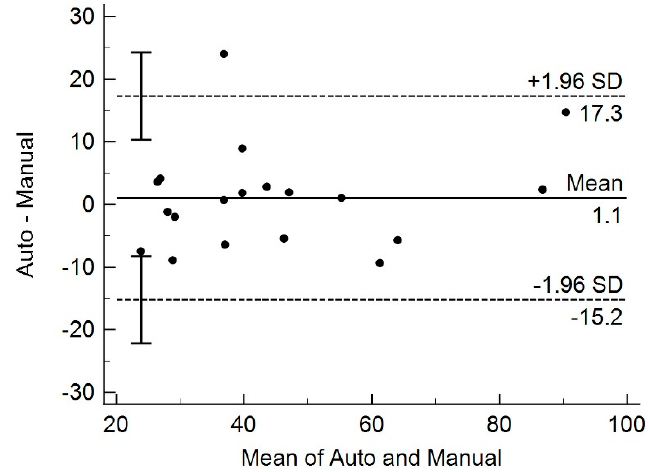
Figure 4. Bland–Altman plot of prostate volume measured by automatic and manual methods. All but one measurement differed within 1.96 standard deviation, indicating no systematic variation between the two measurements.